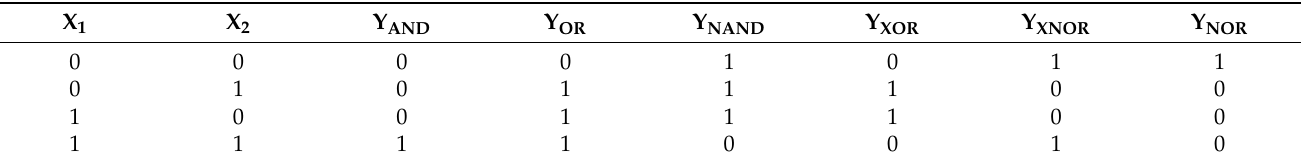
Table 1. Logic gate truth